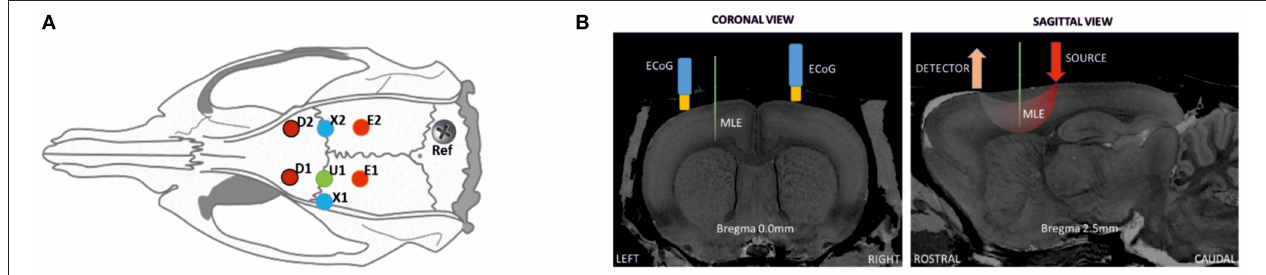
FIGURE 1 | Schematic representation of the location of ECoG and optical probes on a rat head. (A) Positions for optical probes, MLE, and ECoG electrodes in the rat cortex: D1 and D2, detectors of the spectrometers [anterior-posterior (AP) 2.5mm medial-lateral (ML) 2.5mm]; E1 and E2, correspond to the position of emitter 1 (ipsilateral) and emitter 2 (contralateral). ECoG electrodes (X1 at AP 0mm ML 3.5mm; X2 at AP 0mm ML 2.5mm); and U1, multi-site linear electrode (AP 0mm ML 2.5mm), with its reference. (B) Coronal and sagittal views in the MRI atlas for Sprague-Dawley rats (27). Left side: the MLE and ECoG electrodes at Bregma 0.0mm, coronal slice. Right side; detector and light source optode placement with MLE, sagittal slice (Bregma 2.5mm).